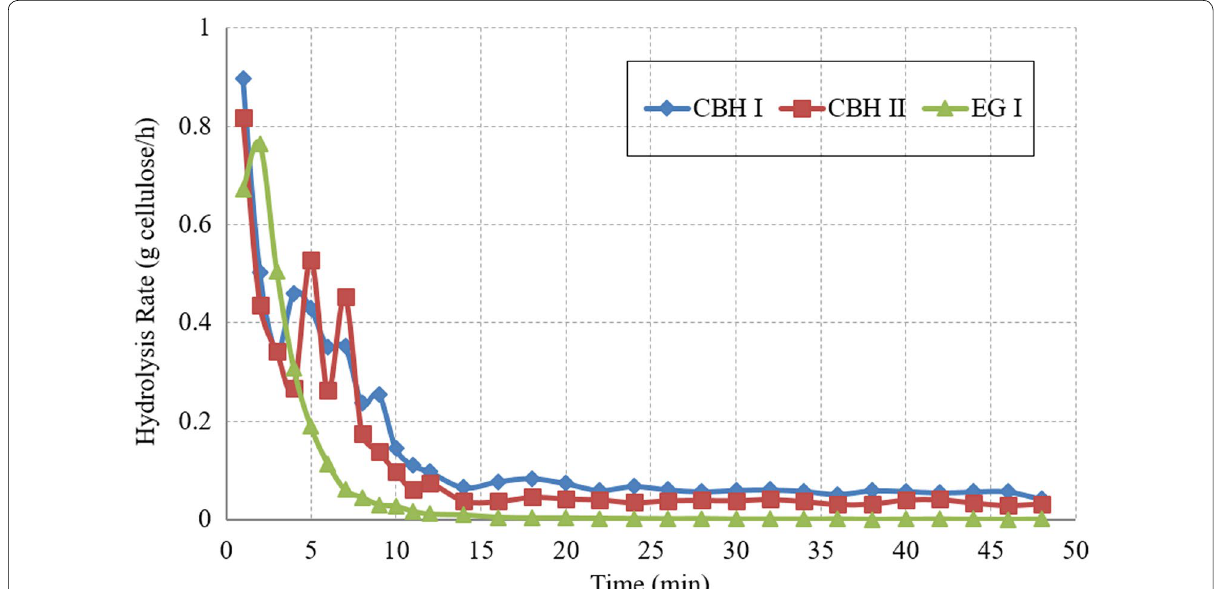
Fig. 15 Model predictions of hydrolysis rate by action of individual enzymes on filter paper (filter paper, 25 g/L; all enzymes, 10 mg/g